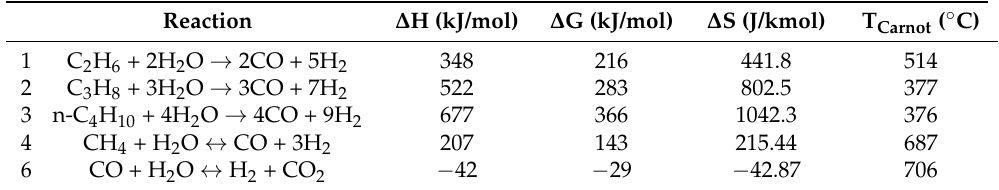
Table 2. Pre-reforming reactions [25].